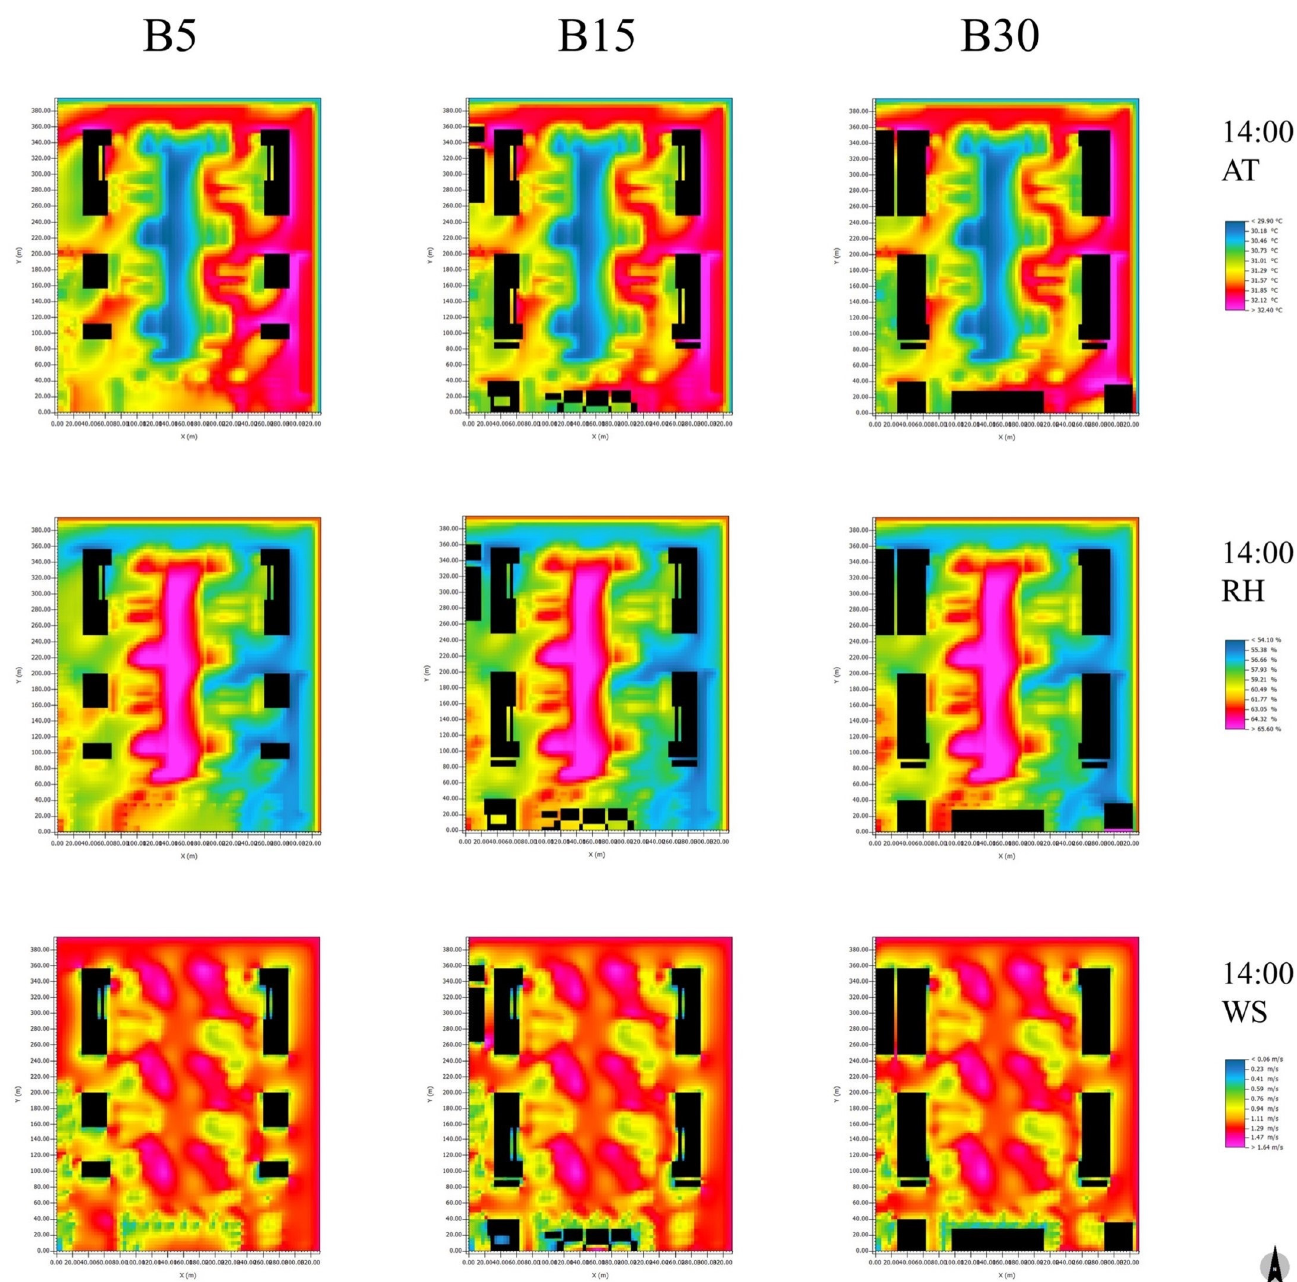
Figure 9. Distribution maps of microclimate parameters at 14:00 with redesigned building heights and